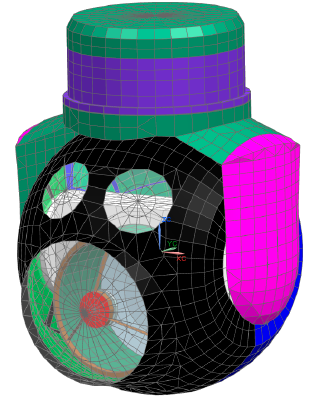
Figure 4. Model of the optoelectronic sensor for thermal analysis.